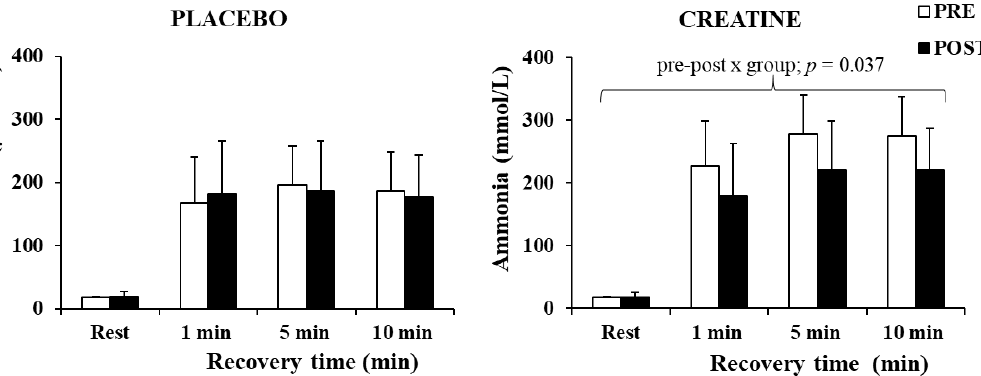
Figure 5. Plasma ammonia at rest and following 1, 5, and 10 min of recovery after the sprint test, pre- and post-supplementation for each group.